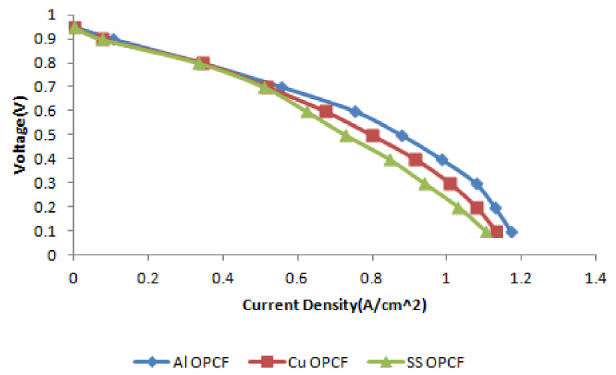
Figure 5. Hydrogen humidification temperature 60 ◦ C.